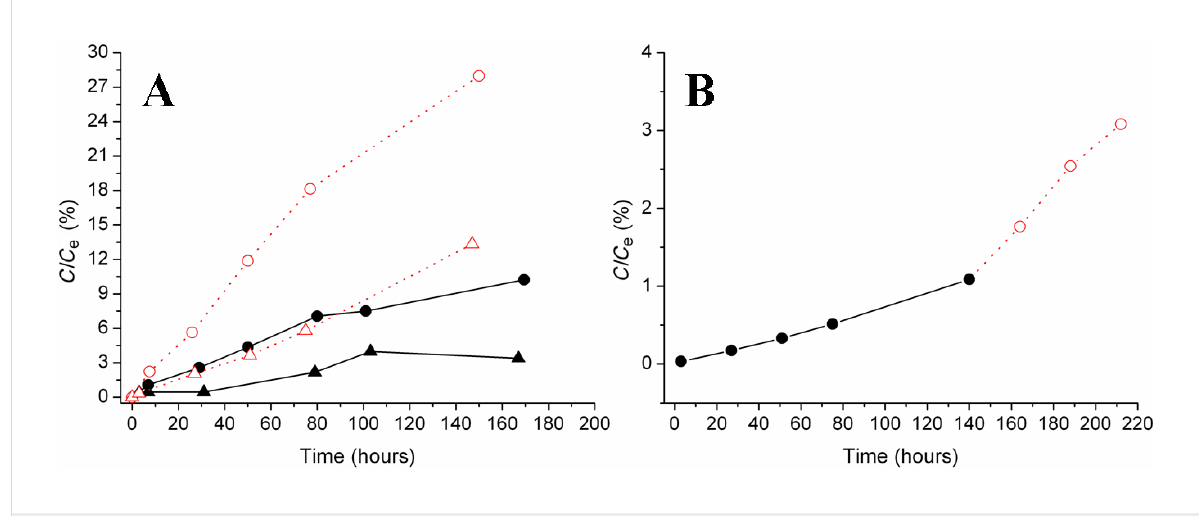
Figure 4: Concentration of probe molecules transported through the silica nanoparticle-functionalized microsieve. Section A: diffusion (black symbols, black solid lines) and migration (red symbols, red dotted lines) of MB (circle) and RNAse (triangle). Section B: diffusion (black circle, black solid line) followed by migration after 140 h (red circle, red dotted line) of MB in a mixed solution containing both MB and RNAse.